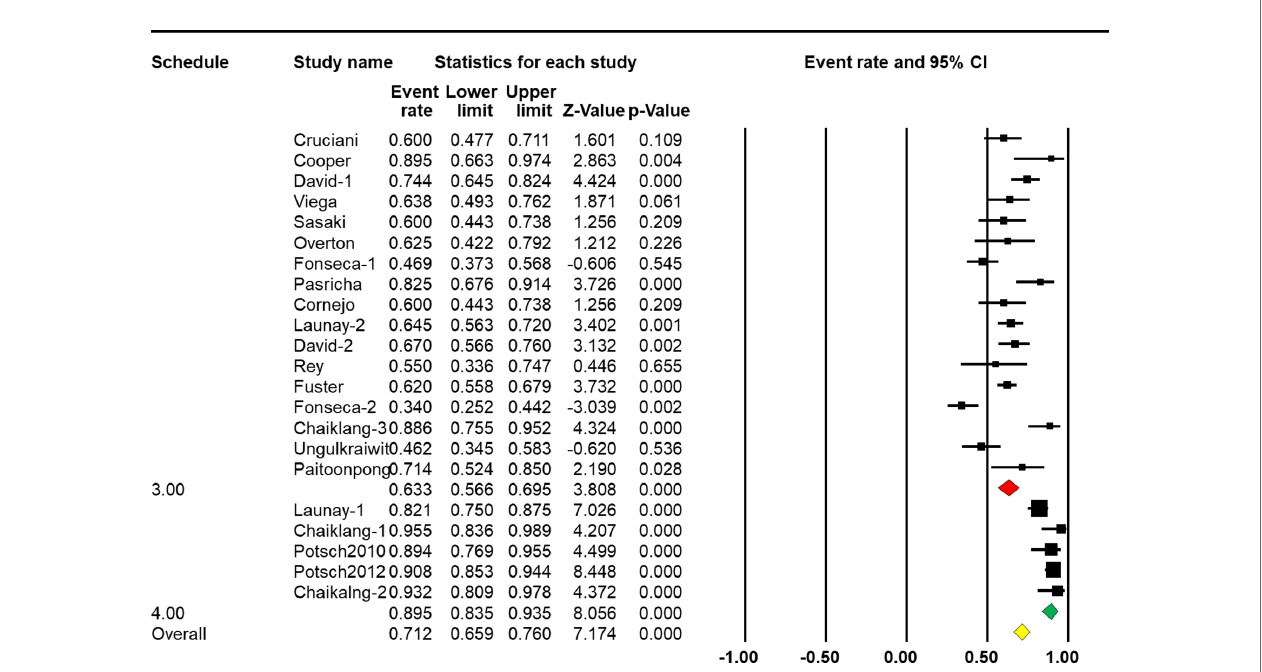
FIGURE 5 | Ef fi cacy of HBV vaccination with different schedules (three-dose vs. four-dose) on the response